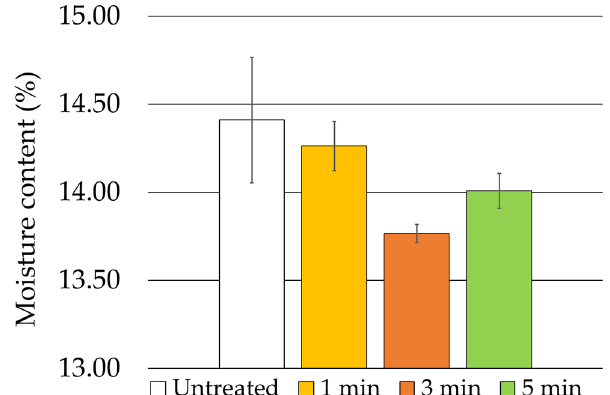
Figure 3. Change in the moisture content of wheat flour (type 550) as a function of NTP treatment time.